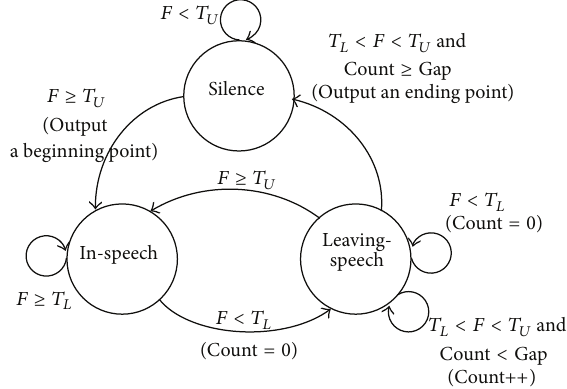
Figure 2: State transition model diagram for endpoint detection